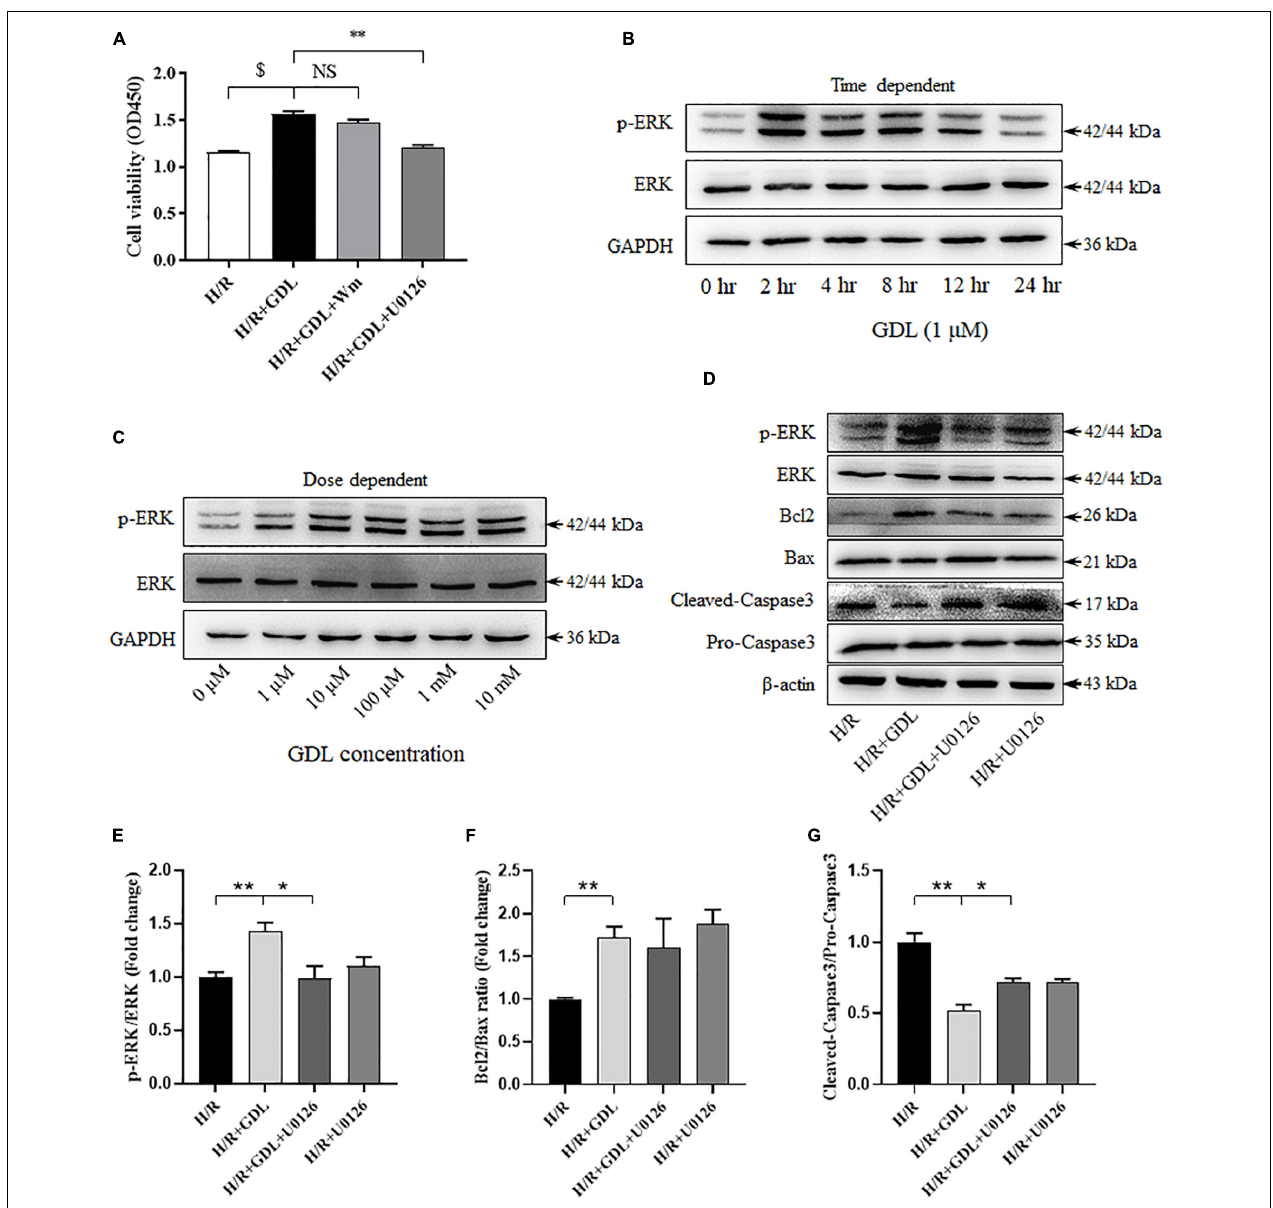
FIGURE 5 | Extracellular signal-regulated kinase signaling contributed to GDL-conferred cardioprotection against H/R injury. (A) The effect of MEK/ERK inhibitor U0126 (10 µ M) or PI3K/Akt inhibitor Wortmannin (Wm; 100 nM) on GDL-induced cardioprotection against H/R injury. (B) Time-dependent effect of GDL (0, 2, 4, 8, 12, and 24 h) on ERK expression and phosphorylation by Western blot analysis. (C) Dose-dependent effect of GDL (0 µ M, 1 µ M, 10 µ M, 100 µ M, 1 mM and 10 mM) on ERK expression and phosphorylation by Western blot analysis. (D–G) Representative images and Western blot analysis of apoptosis-related proteins (Bcl2, Bax, and Caspase3) and pro-survival ERK signaling in H/R, H/R + GDL, H/R + GDL + U0126, H/R + U0126 groups. * P < 0.05 and ** P < 0.01 between indicated groups. NS, not significant. Data shown are representive of five independent